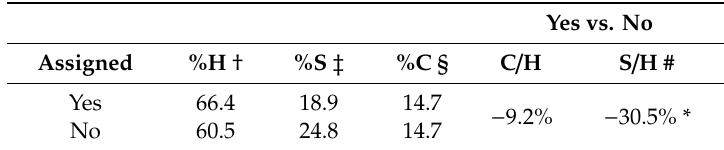
Table 7. Percent hybrid (H), selfs (S), and o ff -type (C) and the percent di ff erence from the odds ratio of o ff -type to hybrid and self to hybrid for assigned to not